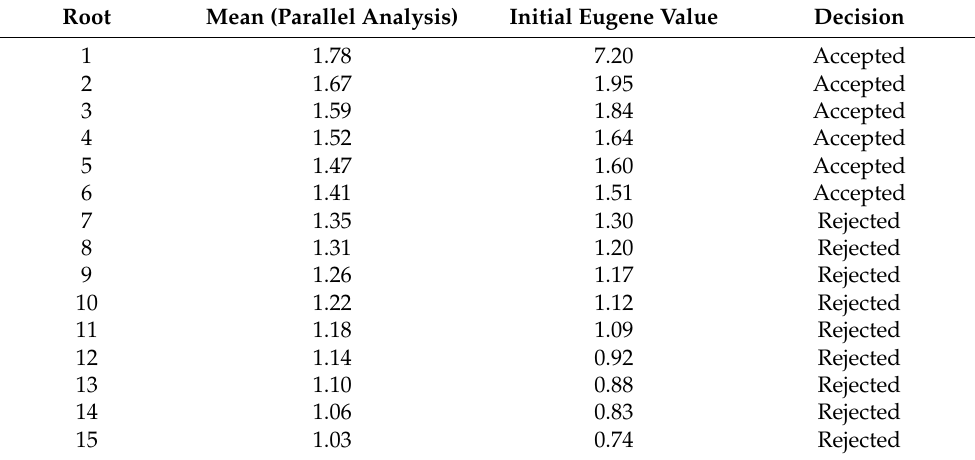
Figure 1. Scree plot. Table 5. Parallel